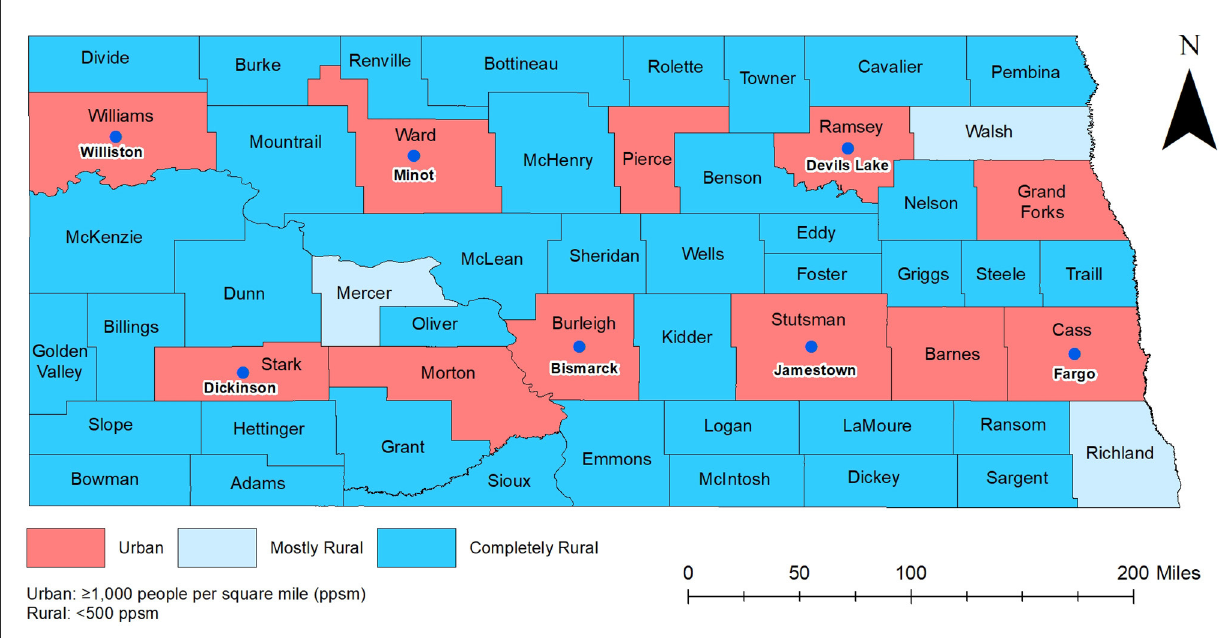
FIGURE1 Map of North Dakota showing geographic distribution of urban and rural counties.